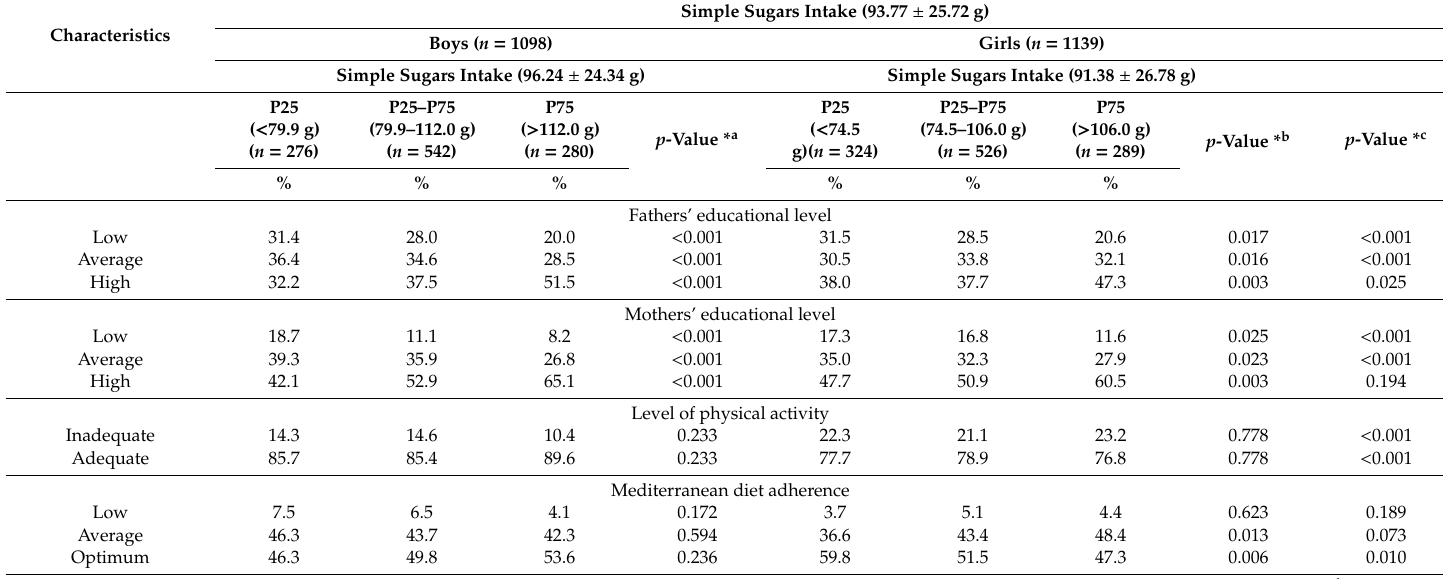
Table 3. Sociodemographic characteristics of schoolchildren in relation to sugar intake consumed by 6–8 years old children ( n = 2237) in Valencia, Spain, 2018.